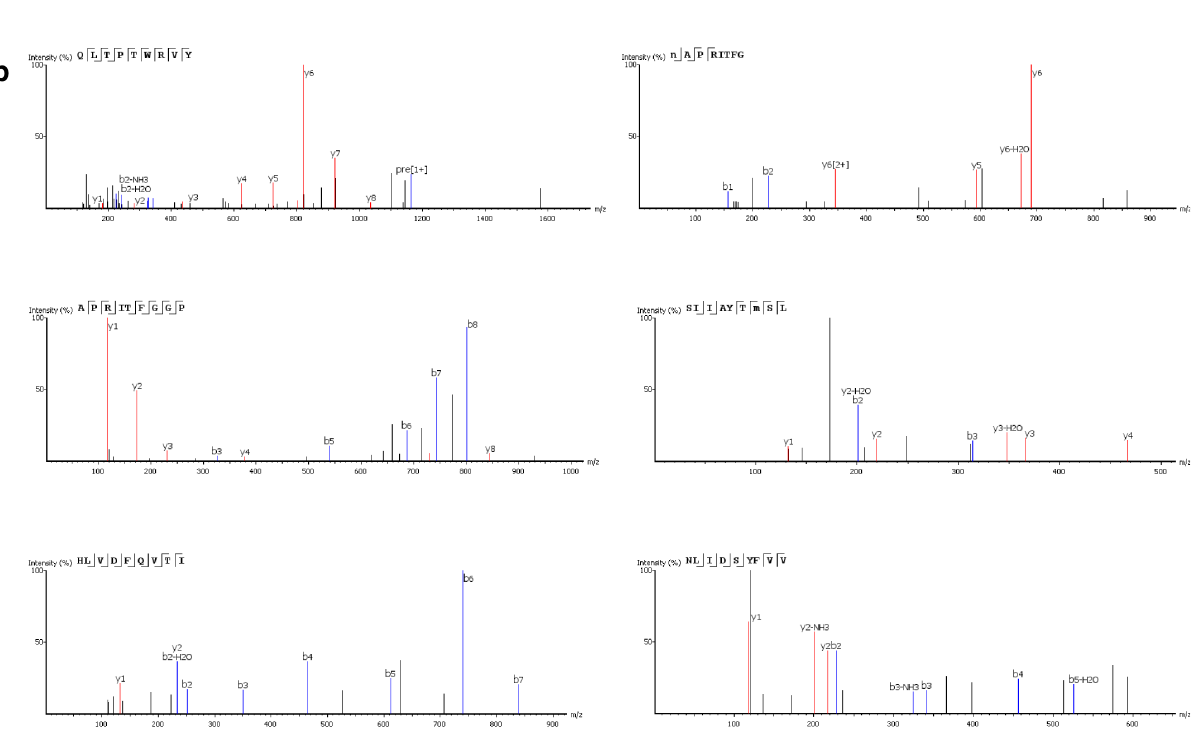
Fig. 4 New T-cell epitopes identi fi ed by our platform from SARS-CoV-2-infected A549 cells and HEK293T cells. a Detailed information of the T cell epitopes. b Peptide-spectrum matches of the T cell epitopes. (MHC: Major Histocompatibility Complex; HLA: Human Leukocyte Antigen; IEDB: Immune Epitope